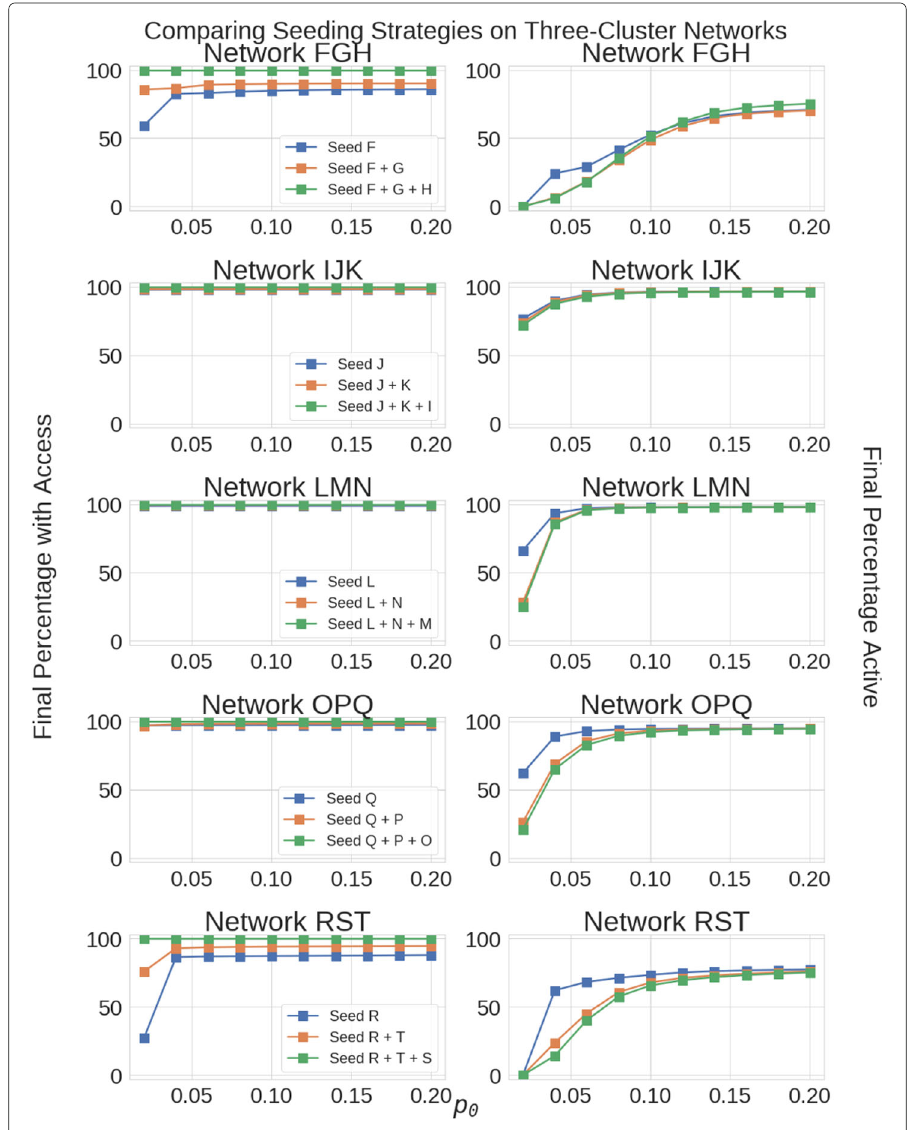
Fig. 3 Comparison of cluster-based seeding approaches in the repeated-usage model. Different rows correspond to different three-cluster networks from Table 2 of Iyer and Adamic (2018). The left-hand column shows the average asymptotic percentage of the population with access; the right-hand column shows the average asymptotic percentage that is active. Legends are shared by the left and right panels in each row. The parameters s i = 2 and δ = 0.005 in these simulations. Each data point is an average over 50 simulations. In this and all subsequent plots, we include 95% confidence intervals, but they are sometimes smaller than the plot